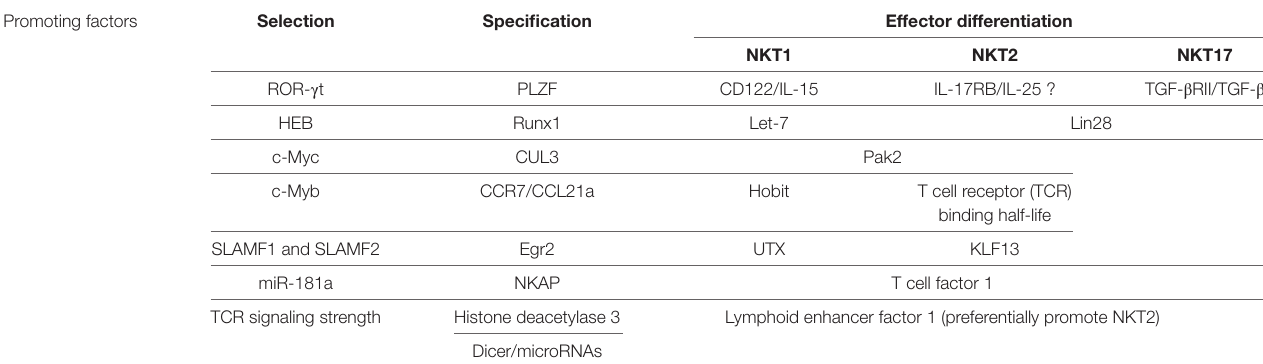
TABLe 1 | Genetic factors influence development of iNKT subsets. Promoting